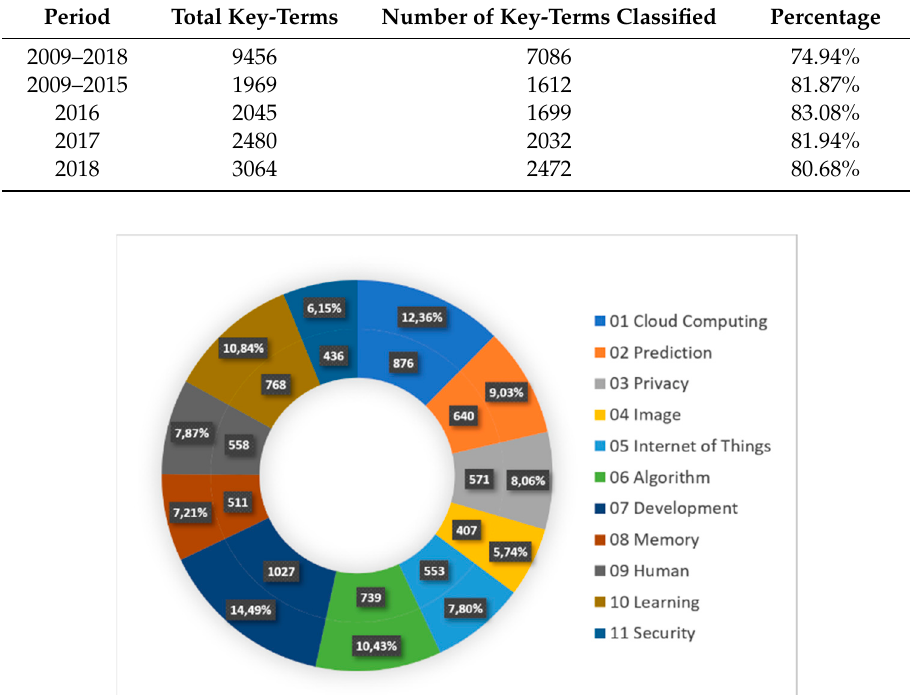
Figure 8. The number of key-terms in each cluster for the period 2009–2018.